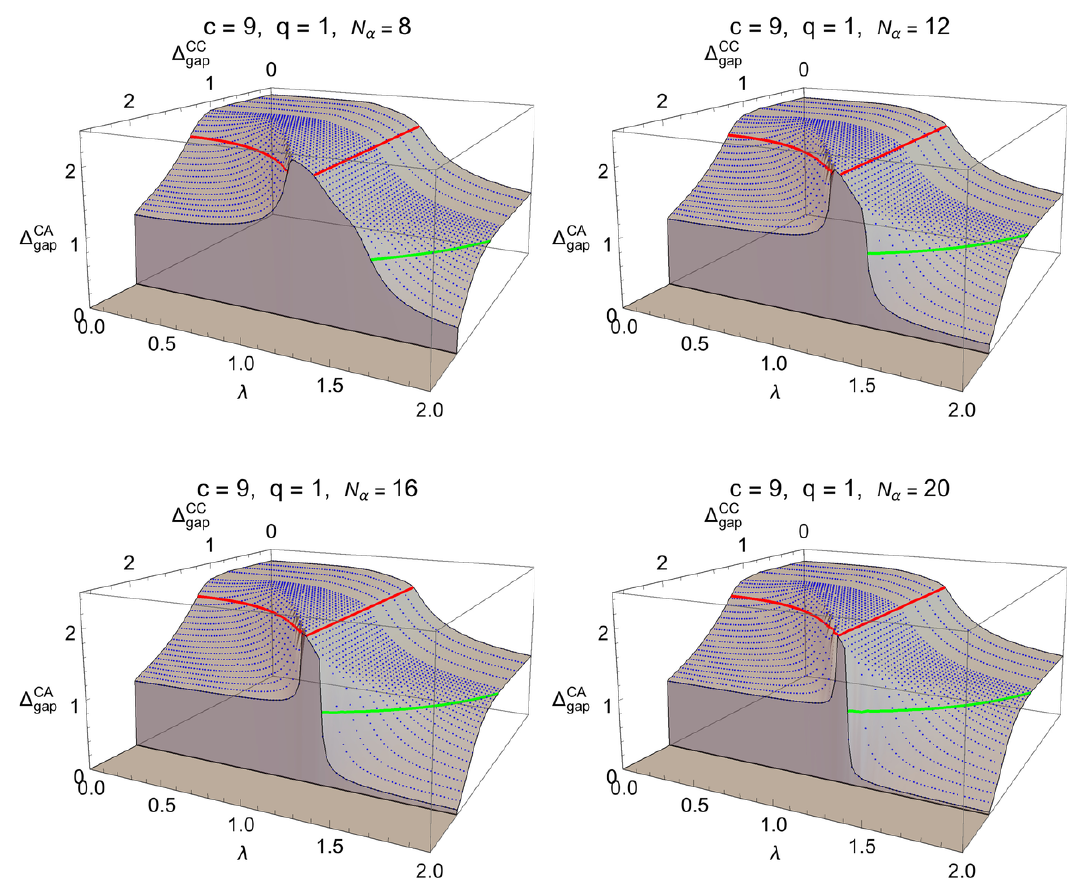
Figure 10. Upper bounds on the gap in the CA channel (cid:1) CA the case of c = 9 and q = 1, at derivative orders 8, 12, 16, and 20. The green and red curves are the contours of (cid:1) CA = 1 and 2, respectively, on the bounding surface. There is an overall upper gap